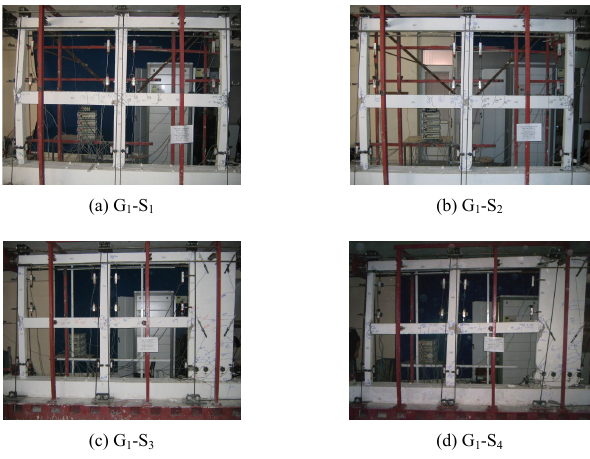
Figure 5. Post-test views of the 1 st group test specimens (Arslan, 2007) Fig. 5. Post-test views of the 1st group test specimens (Arslan,